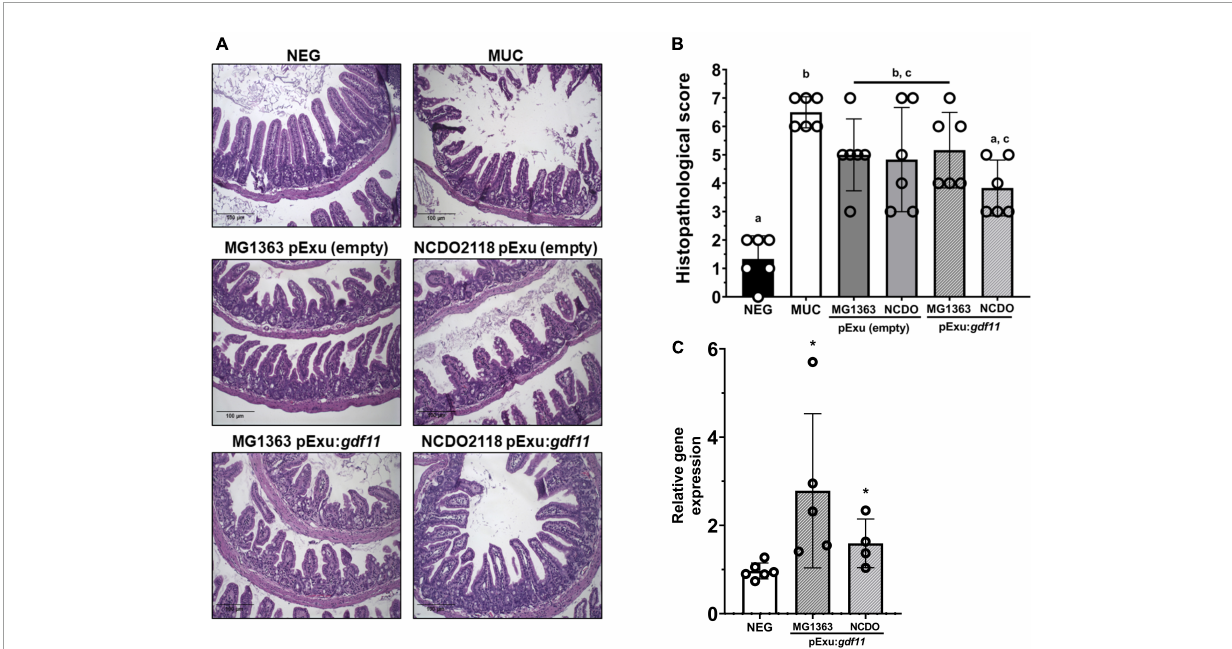
FIGURE2 Protective effect of recombinant L. lactis (pExu: gdf11 ) on histopathological mucosa damaged by 5-FU and Gdf11 expression. (A) Representative photomicrographs of experimental groups captured in 20X objective, scale 100 µ m. (B) Histopathological score ( n = 6) of mucosal damage caused by 5-FU. Median of the total score. Different letters (a, b, and c) indicate a significant difference ( p < 0.05) among groups through Kruskal–Wallis analysis, followed by Dunn’s multiple comparison test. (C) Relative expression of Gdf11 in the ileum of mice ( n = 4–6) following 2 (cid:49)(cid:49) Ct method of analysis. Statistical significance was indicated by *( p < 0.05) followed by Student’s t